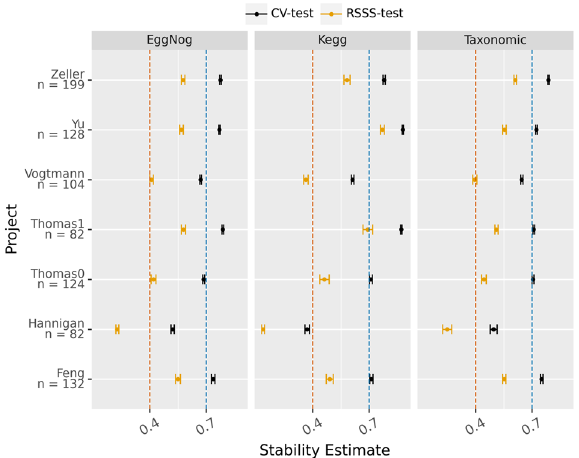
Figure 1. Stability estimate along with the confidence interval (alpha = 0.05) for the Random Stability Sub Sampling (RSSS-test) and 20-times tenfold cross validation (CV-test) splitting schemas, for each metagenomic profile (KEGG, eggNog and taxonomic) and project. The vertical bars indicate the theoretical thresholds on the effect size: below 0.4 represent bad agreement, between o.4 and 0.7 refers to a good enough agreement and scores above 0.7 represent a near perfect agreement.